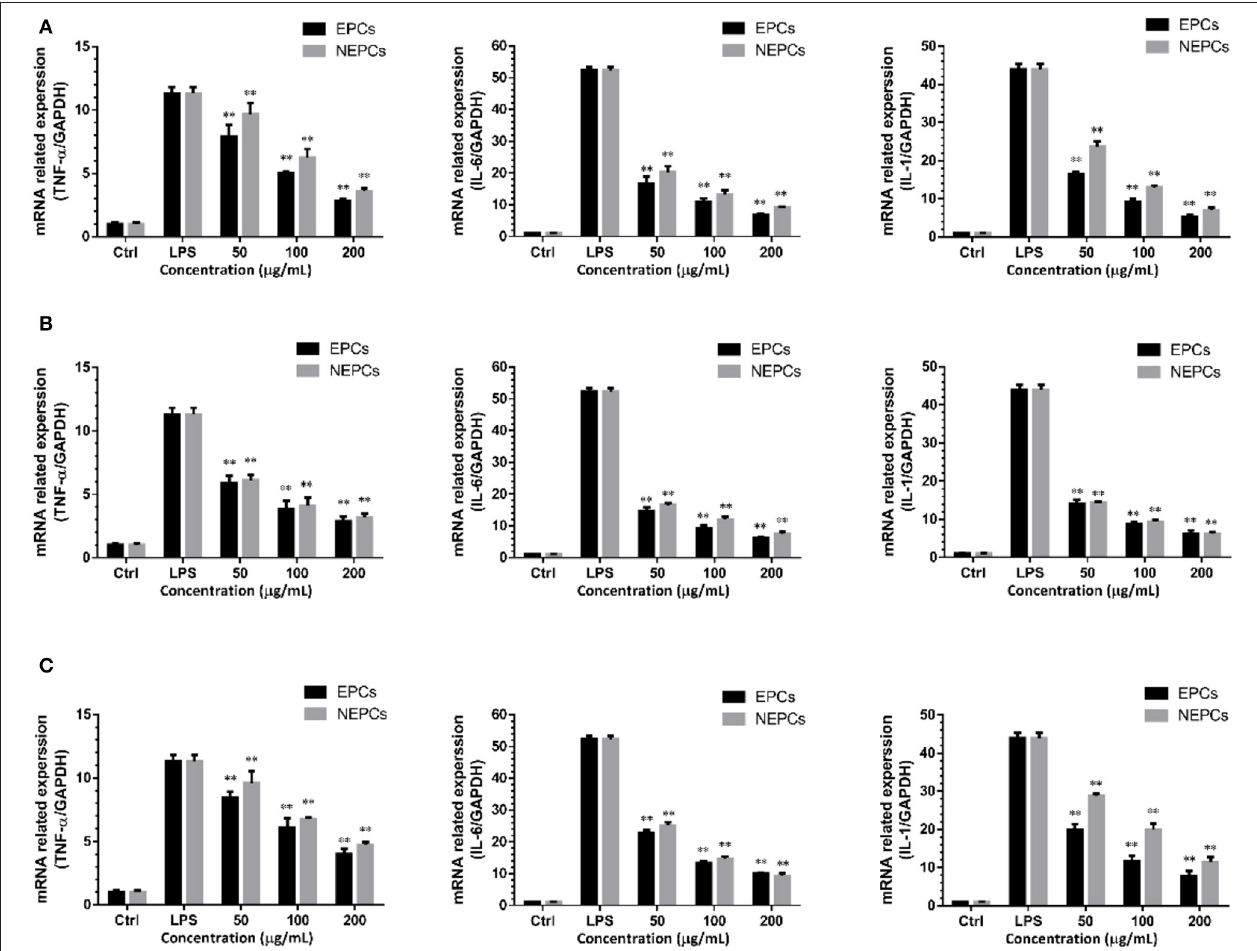
FIGURE 3 | Suppressive effects of EPCs and NEPCs from L. japonica (A) , U. lactuca (B) , P. tenera (C) on mRNA expression of TNF- α , IL-6, IL-1 in activated macrophages. Results were expressed as mean ± SD ( n = 6). * p < 0. 05 and ** p < 0.01 indicate statistically differences from LPS-treated